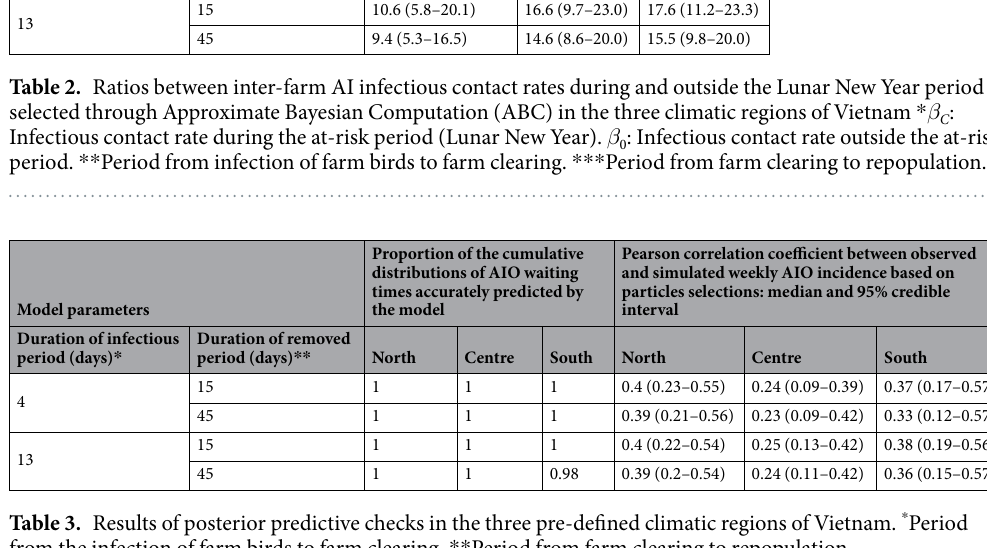
Table 3. Results of posterior predictive checks in the three pre-defined climatic regions of Vietnam. * Period from the infection of farm birds to farm clearing. ** Period from farm clearing to